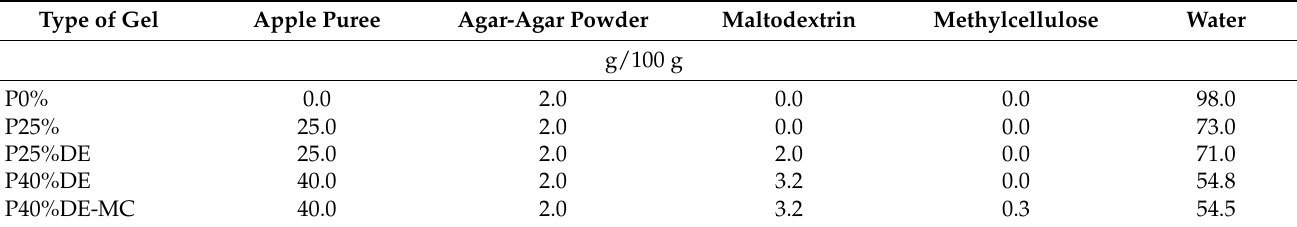
Table 1. Composition of